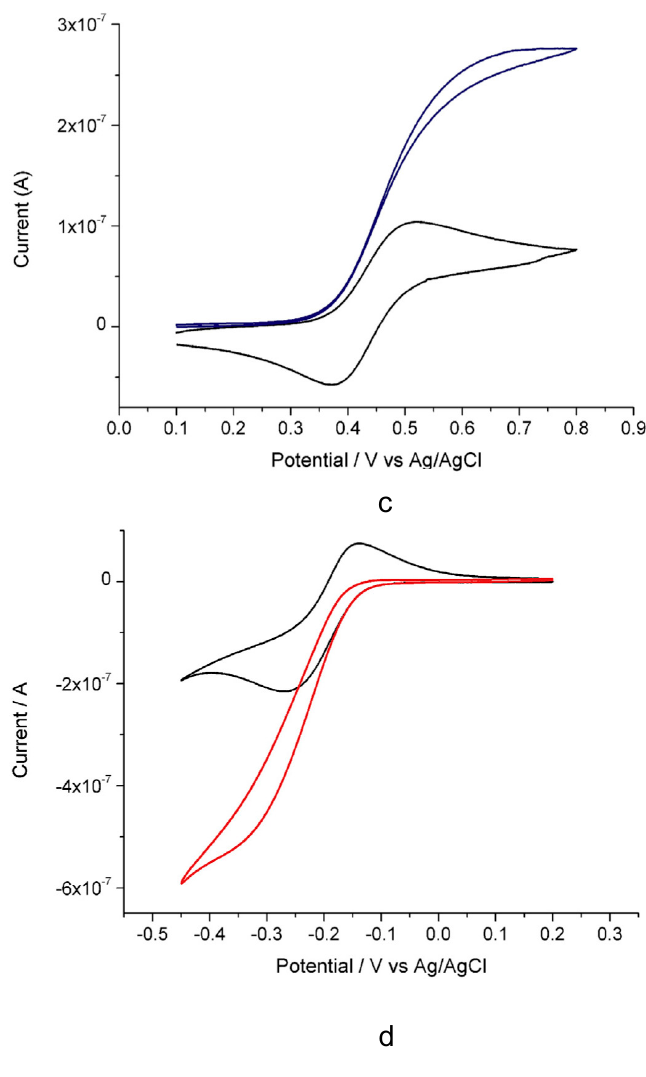
Figure 8. ( A ): Scheme of the immunosensor. ( B ): Cyclic Voltammograms reported on the left show: ( a ) CVs of OVA-immunosensor after incubation in the extract canvas, before and after the addition of glucose; ( b ) CVs of methylene blue at NEE IgY immunosensors incubated with canvas sample, before and after the addition of hydrogen peroxide. ( c ) and ( d ) show the same conditions of ( a ) and ( b ) but working with the original sampled Virgin. Reproduced and reprinted with permission from